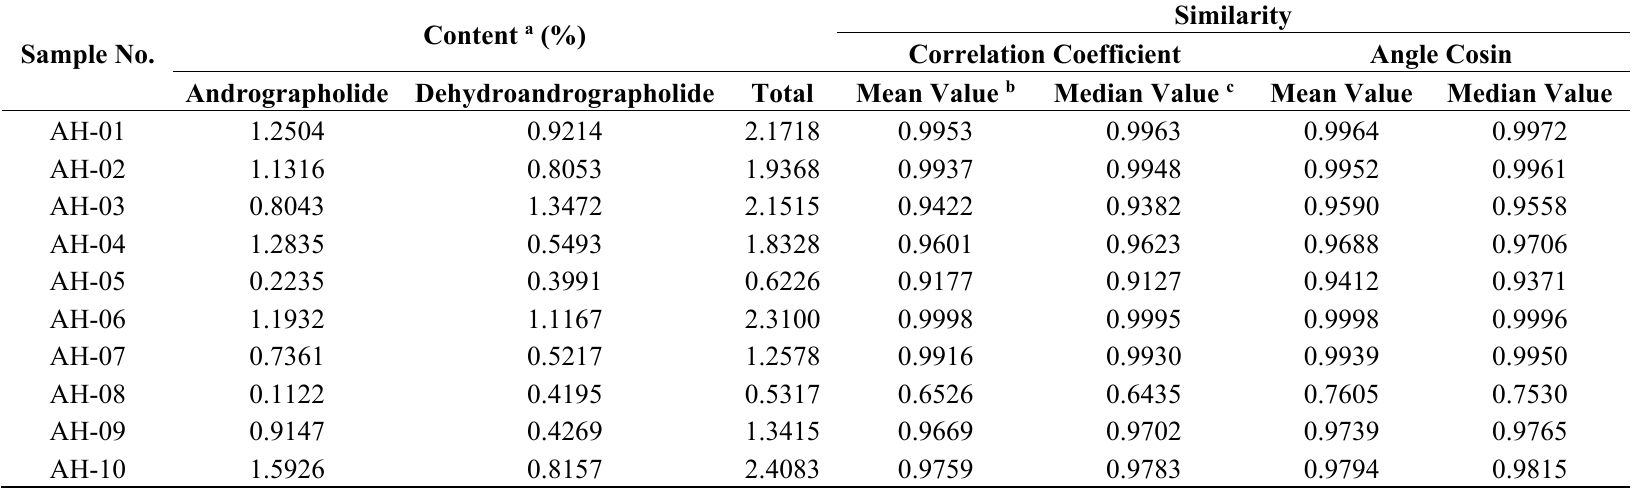
Table 4. Contents of andrographolode and dehydroandrographolide in AH samples and similarity values of each sample compared to the reference fingerprint